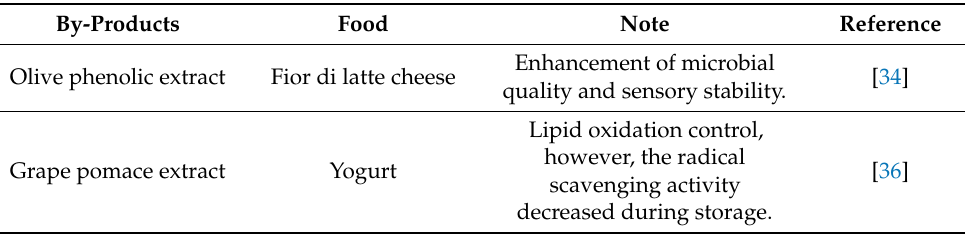
Table 1. Applications of by-products to dairy